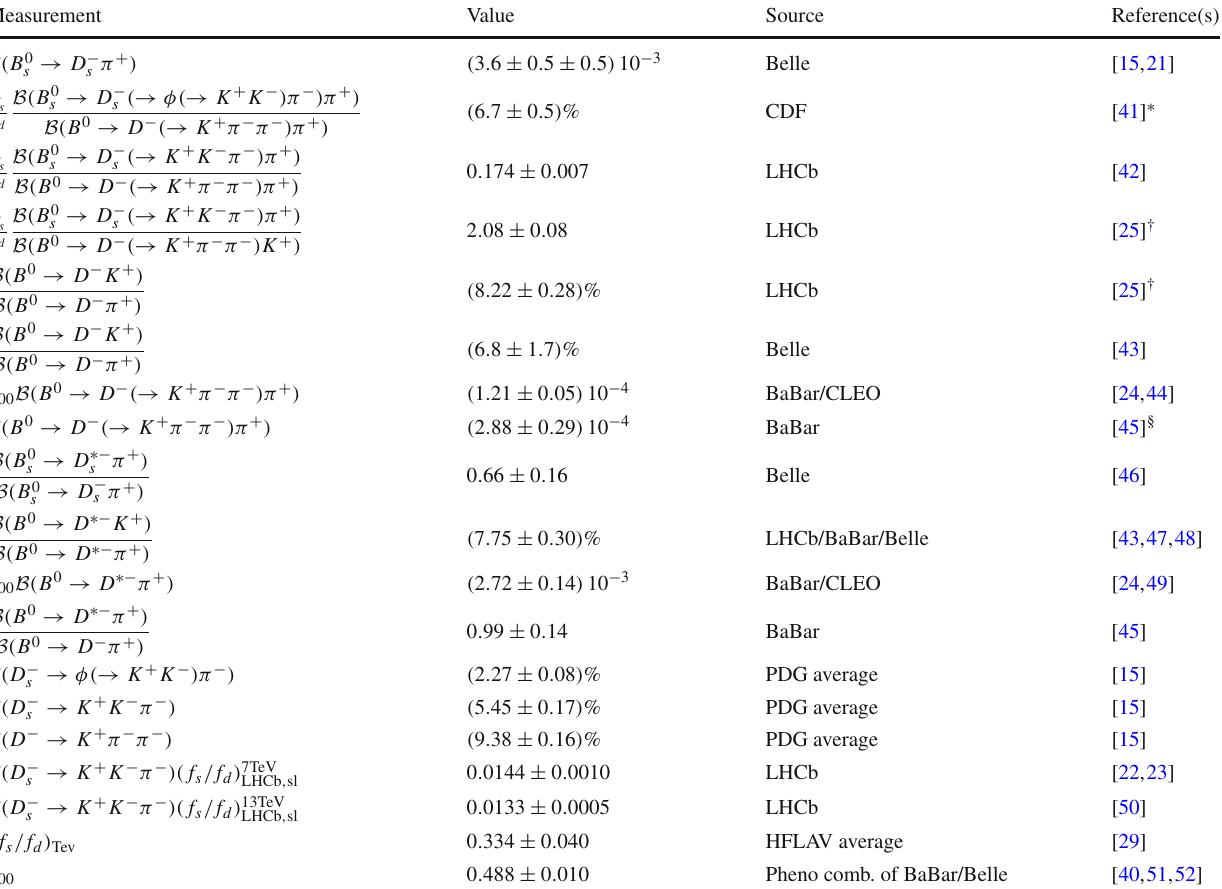
Table 4 Relevant experimental measurements entering our determi- nation of branching fractions and ratios for the considered modes. A ∗ indicates that here f / f s d corresponds to the value at Tevatron, see text. The measurements marked by a † from Ref. [25] have a corre-